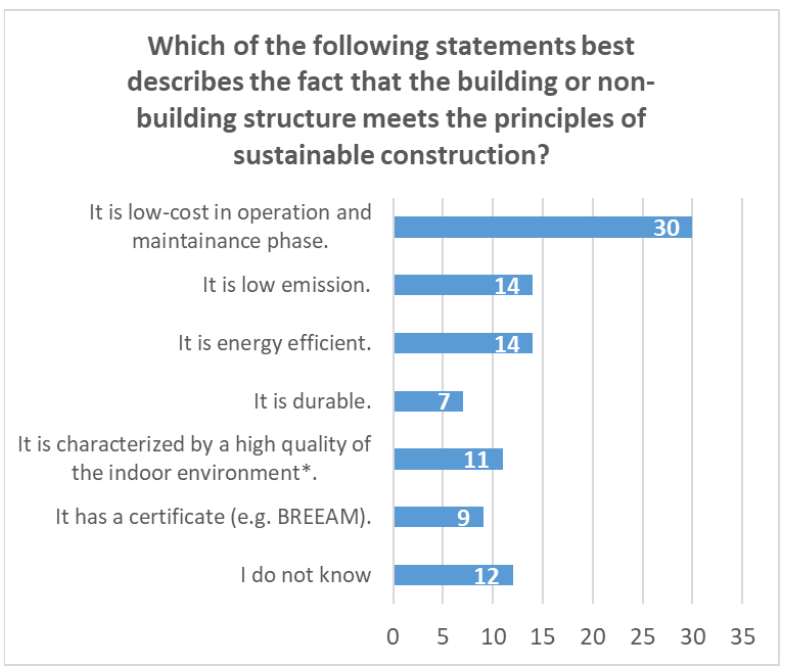
Figure 6. Reasons for sustainable structure (*—applies to buildings).